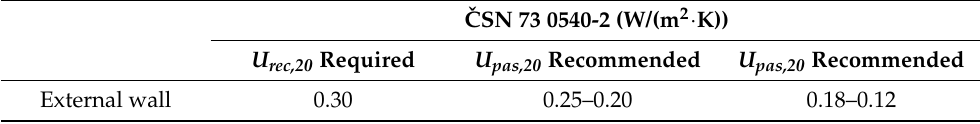
Table 1. Categories for external structures according to standard ˇCSN 73